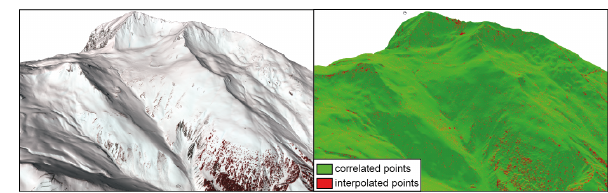
Figure 3. Spatial distribution of image correlation success in a sec- tion of the test site Wannengrat. Visible in the right picture are in- terpolated points (red) mainly over very steep terrain ( > 50 ◦ ), on vegetation and anthropogenic features (e.g., ski